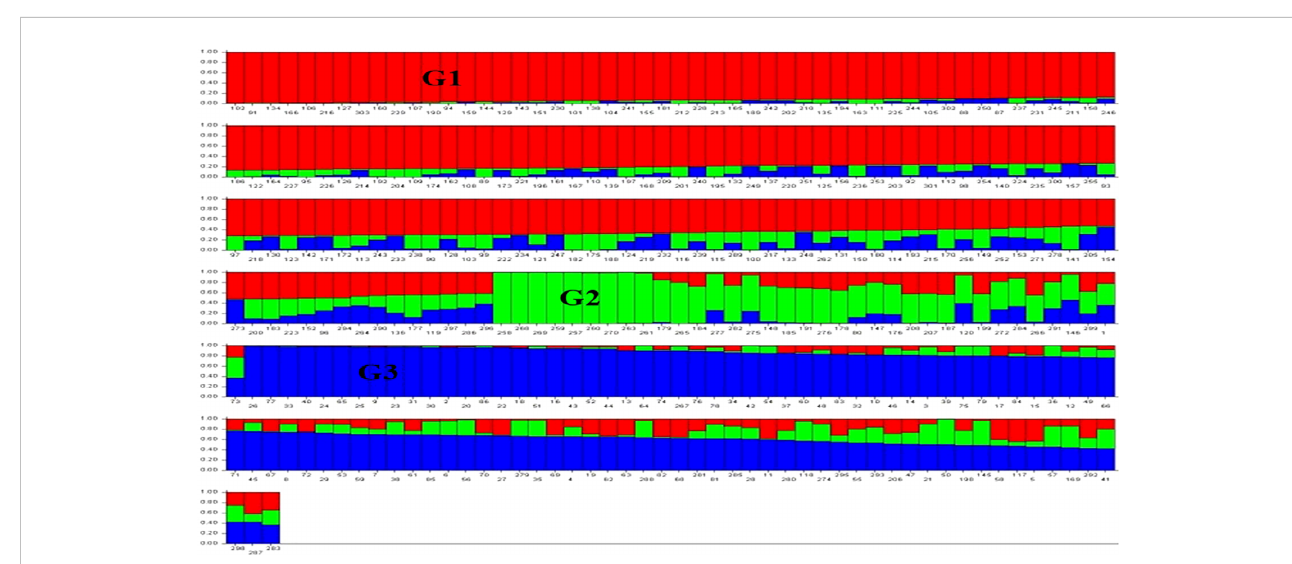
FIGURE 3 Population structure showing three sub-groups (G1, G2, G3) by three different colours (red, green, and blue); the subgroup IV representing admixture had genotypes with more than one color. Each bar represents one